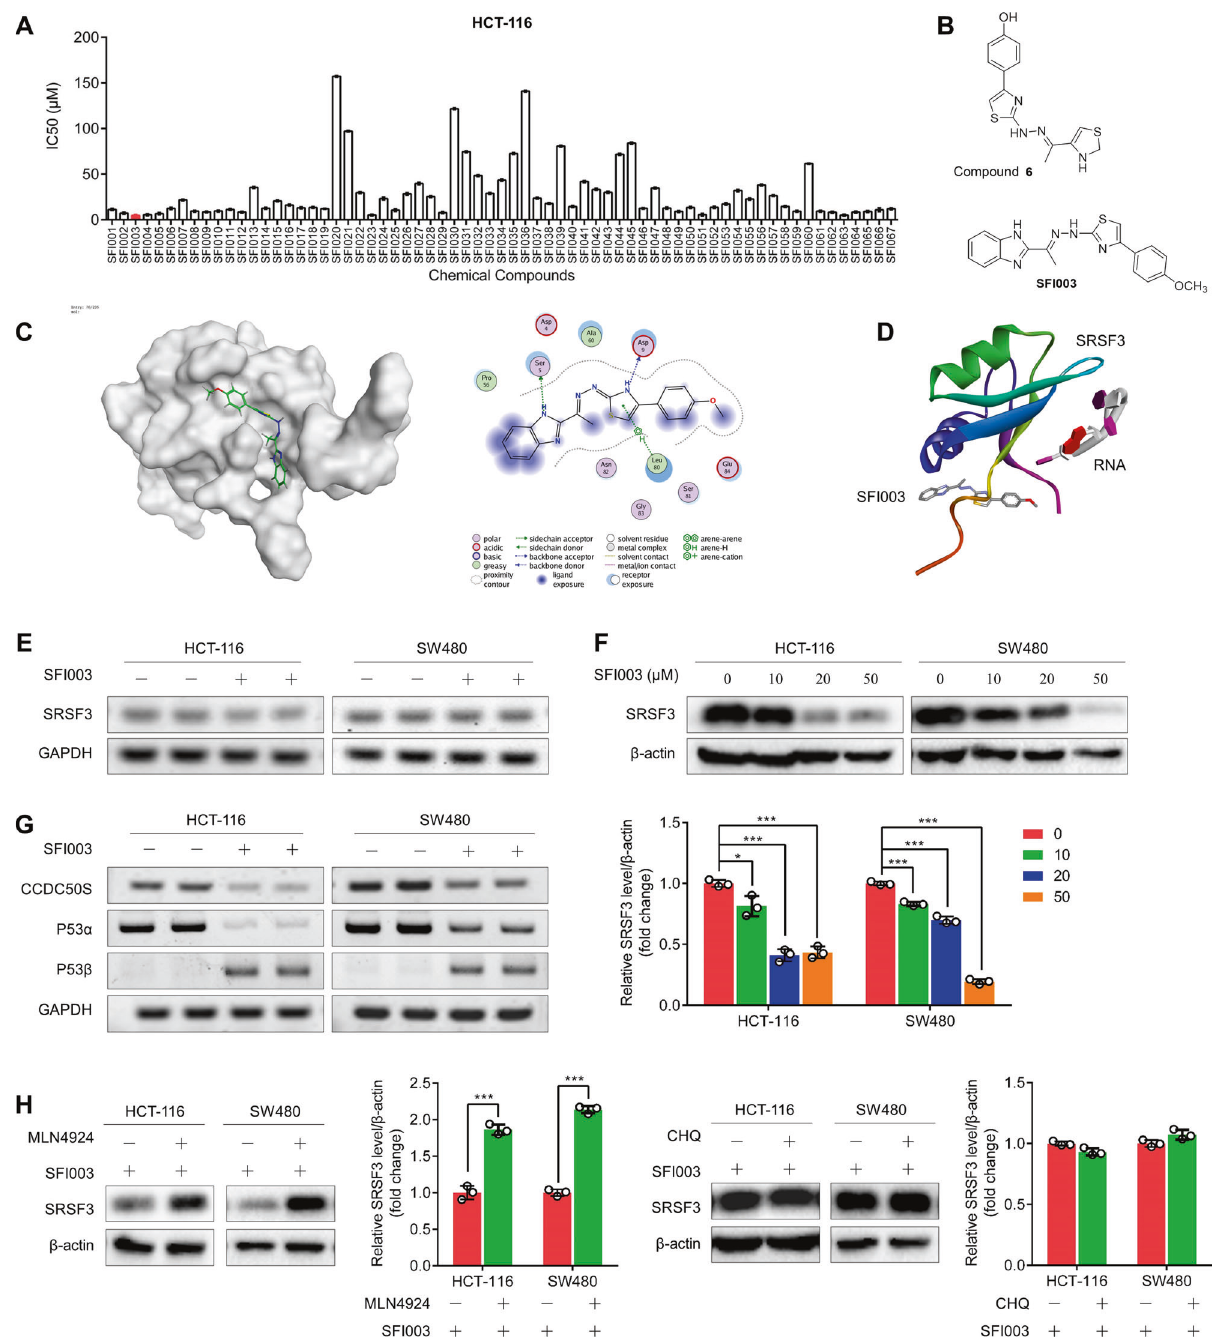
Fig. 3 Discovery of SRSF3 inhibitor SFI003. A The IC50 values of chemical compounds in HCT-116 cells. The cells were treated with the indicated doses of chemical compounds for 72 h. B The chemical structures of compound 6 and SFI003. C The simulated binding modes of SFI003 to the SRSF3 protein with three bonds at residues Ser5, Asp9, and Leu80. D The simulated binding modes of SFI003 and the RNA CAUC, a predicted binding site of SRSF3, on the SRSF3 protein. E RT – PCR results showed the effects of SFI003 (20 μ M) on SRSF3 mRNA expression. F WB results showed the effects of various doses of SFI003 on SRSF3 protein expression. G RT – PCR results showed the effects of SFI003 on the mRNA expression of CCDC50S, P53 α , and P53 β . HCT-116 and SW480 cells were treated with SFI003 at 20 μ M for 72 h. H The effects of MLN4924 and CHQ on SFI003-induced SRSF3 degradation in HCT-116 and SW480 cells. The cells were treated with 20 μ M SFI003 alone for 72 h, 20 μ M SFI003 for 60 h and 3 μ M MLN4924 or 50 μ M CHQ for an additional 12 h. Data represent mean ± SD. Signi fi cance was assessed by two-sided t test. *** P < 0.001; ** P < 0.01; * P < positively correlated with SRSF3 and CA199, a tumor marker, in CRC tissues by IHC staining. We found high expression of this corpus of CRC tissues (Supplementary Table 3). In addition, DHCR24 in 281 (77.2%) CRC tissues (Fig. 2F; Supplementary high expression of DHCR24 and a positive correlation between Table 3), especially adenocarcinoma tissues (OR = 2.38, P = DHCR24 and SRSF3 were also observed in both CPTAC and TCGA 0.036; Supplementary Table 3). Notably, DHCR24 expression was